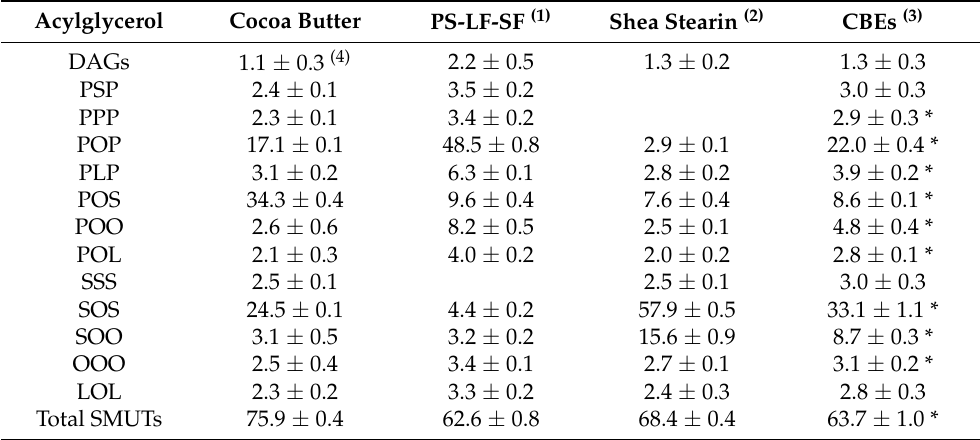
Table 1. Diacylglycerol (DAG) content and triacylglycerol composition ( w/w %) of cocoa butter, PS-LF-SF, shea stearin, and cocoa butter equivalents (CBEs). Acylglycerol Cocoa